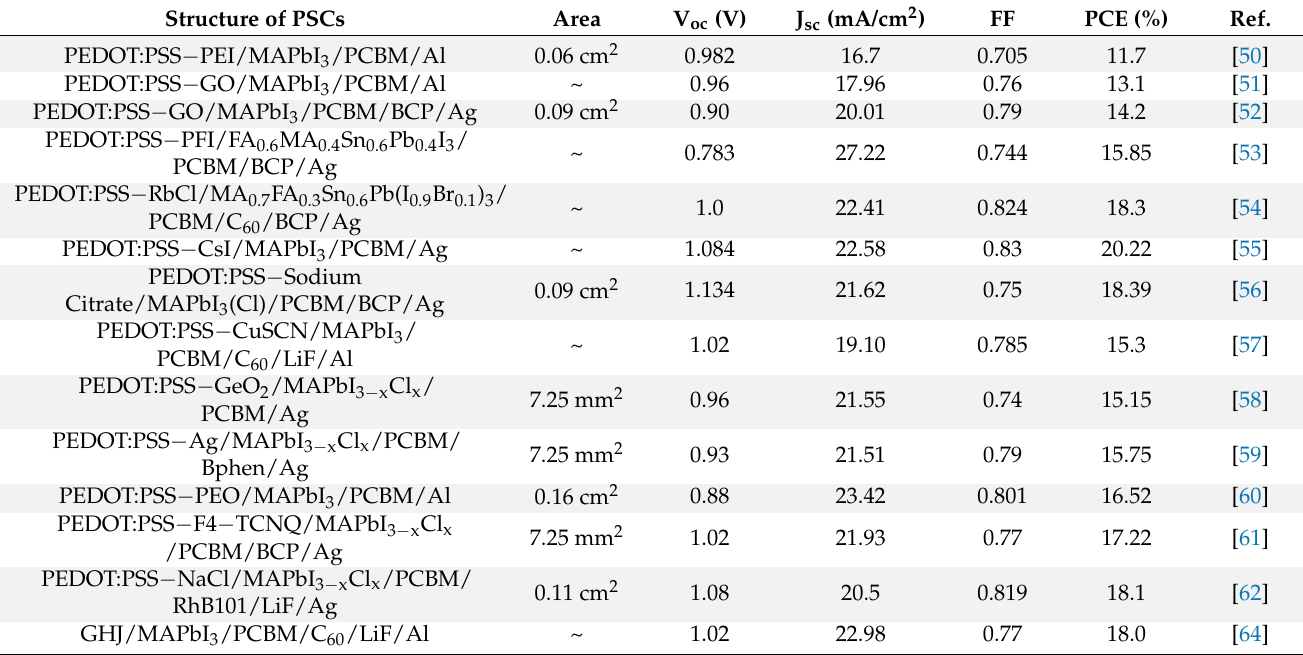
Table 2. Performances of several representative inverted PSCs on the basis of doping PEDOT:PSS with different